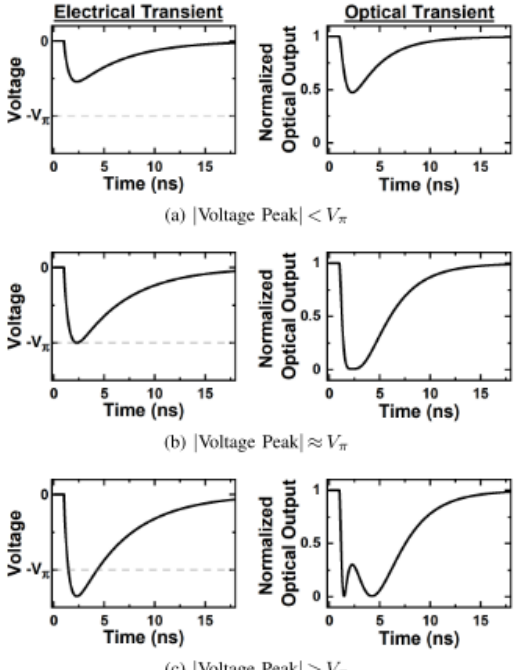
Figure 13. Resultant optical transients (right) caused by electrical transients generated within the MZM driver (left) for a voltage transient that is ( a ) smaller than, ( b ) equal to, and ( c ) larger than the modulator’s V π (after